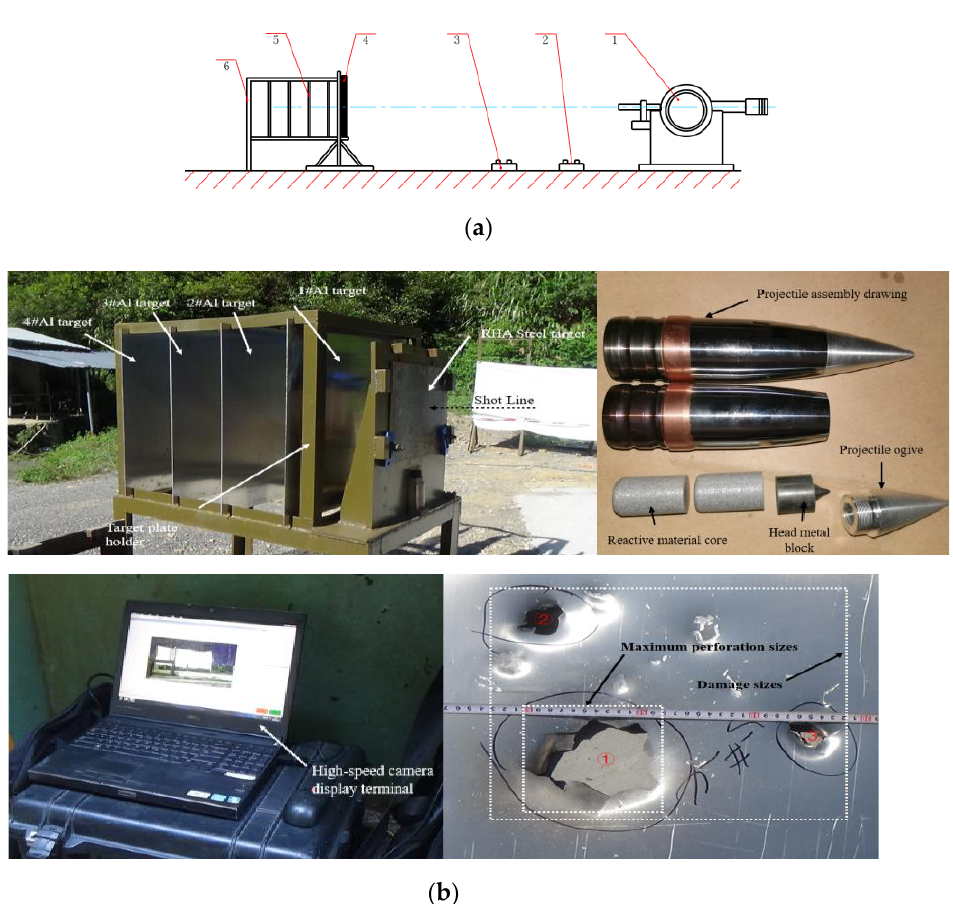
Figure 15. Experimental setup ( a ) Schematic diagram of the experimental layout: 1: 30 caliber artillery; 2, 3: Tianmu tachymeter; 4: RHA steel target; 5: MLAT; 6: target frame. ( b ) On-site layout.